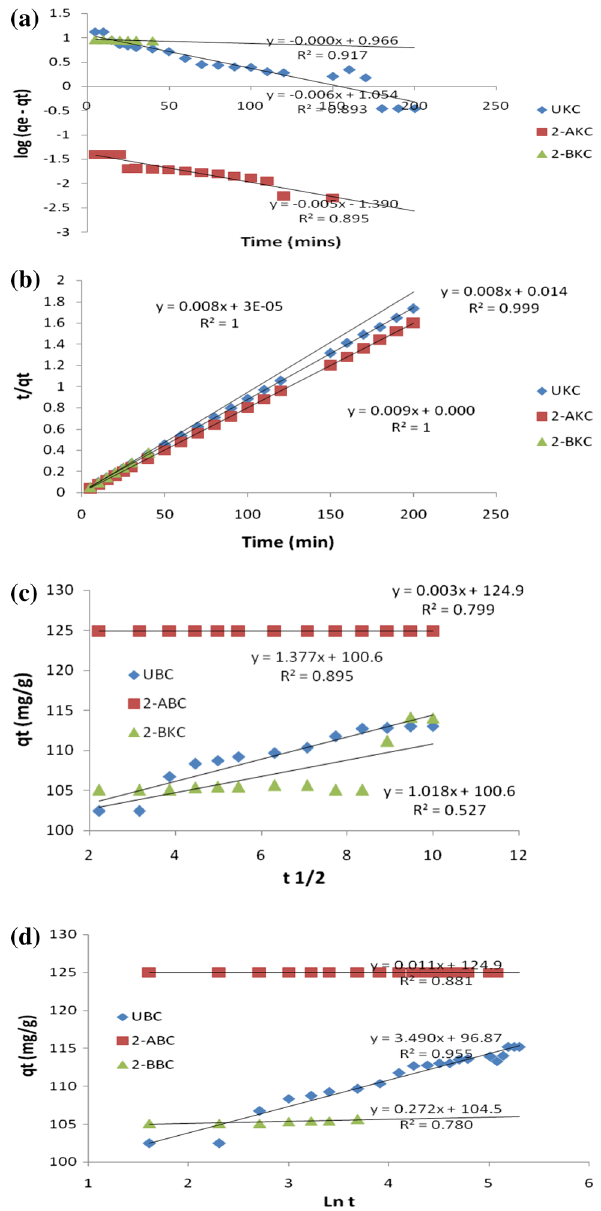
Fig. 8 Thermodynamic plot of adsorption of atrazine with the clay-